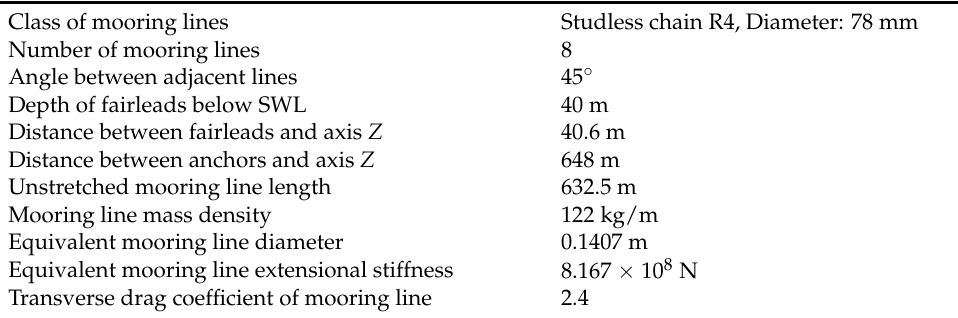
Table 3. Mooring line parameters in water depth of 150